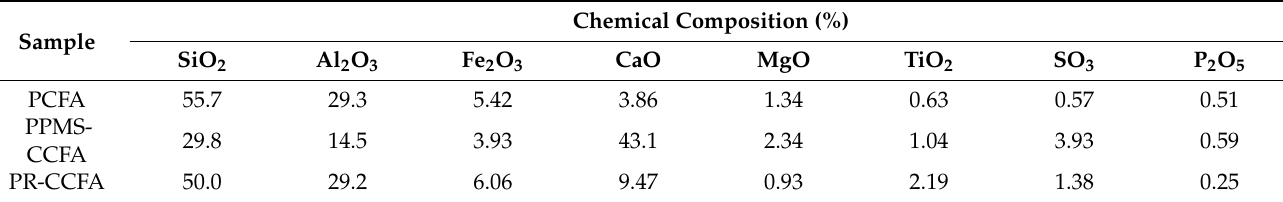
Table 1. Chemical composition of fly ashes by XRF